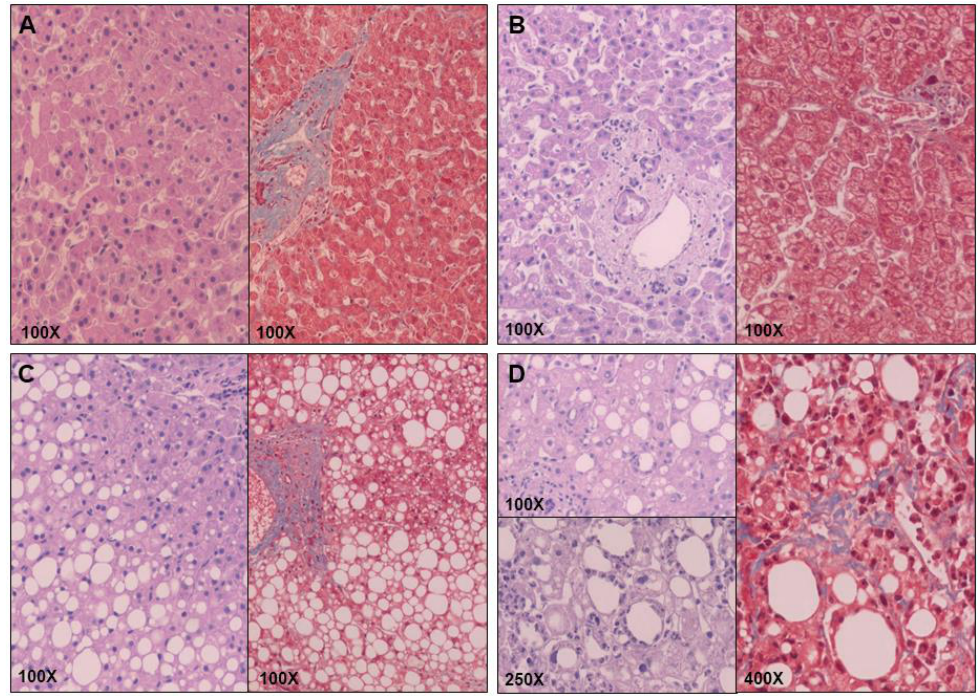
Figure 7. Histological staining with hematoxylin and eosin (purple) and Masson’s trichrome (red) of women with ( A ) NW and NL, ( B ) MO and NL, ( C ) MO and SS, and ( D ) MO and